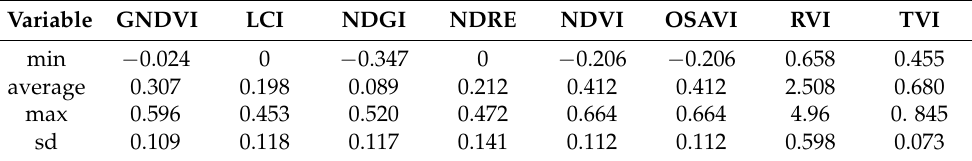
Figure 9. Comparison of the vegetation indices per genus in Mesa del Pawiranachi, NDVI = normal- ized difference vegetation index, GNDVI = green NDVI, LCI = leaf chlorophyll index, NDRE = nor- malized difference red edge index, OSAVI = optimized soil adjusted vegetation index, RVI = ratio vegetation index, TVI = transformed vegetation index, NDGI = normalized difference greenness in- dex.